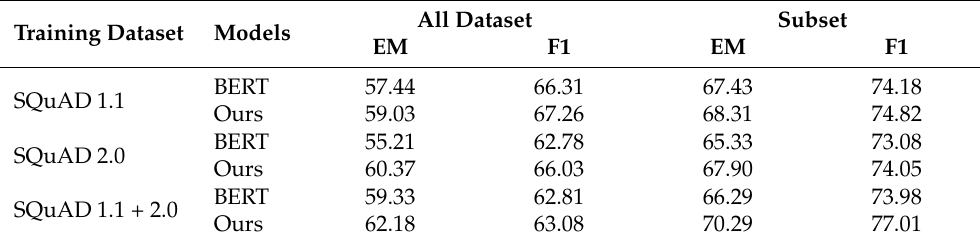
Table 7. Testing results by applying the proposed model to agricultural datasets